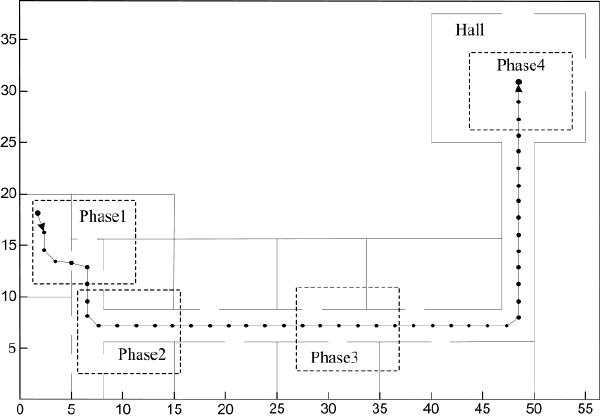
Figure 7. The experimental environments. Phase 1 denotes the visual homing process in the room and the junction between the room and corridor; phase 2 corresponds to the process in the junction between two corridors; phase 3 denotes the process in the corridor; phase 4 corresponds to the process in the